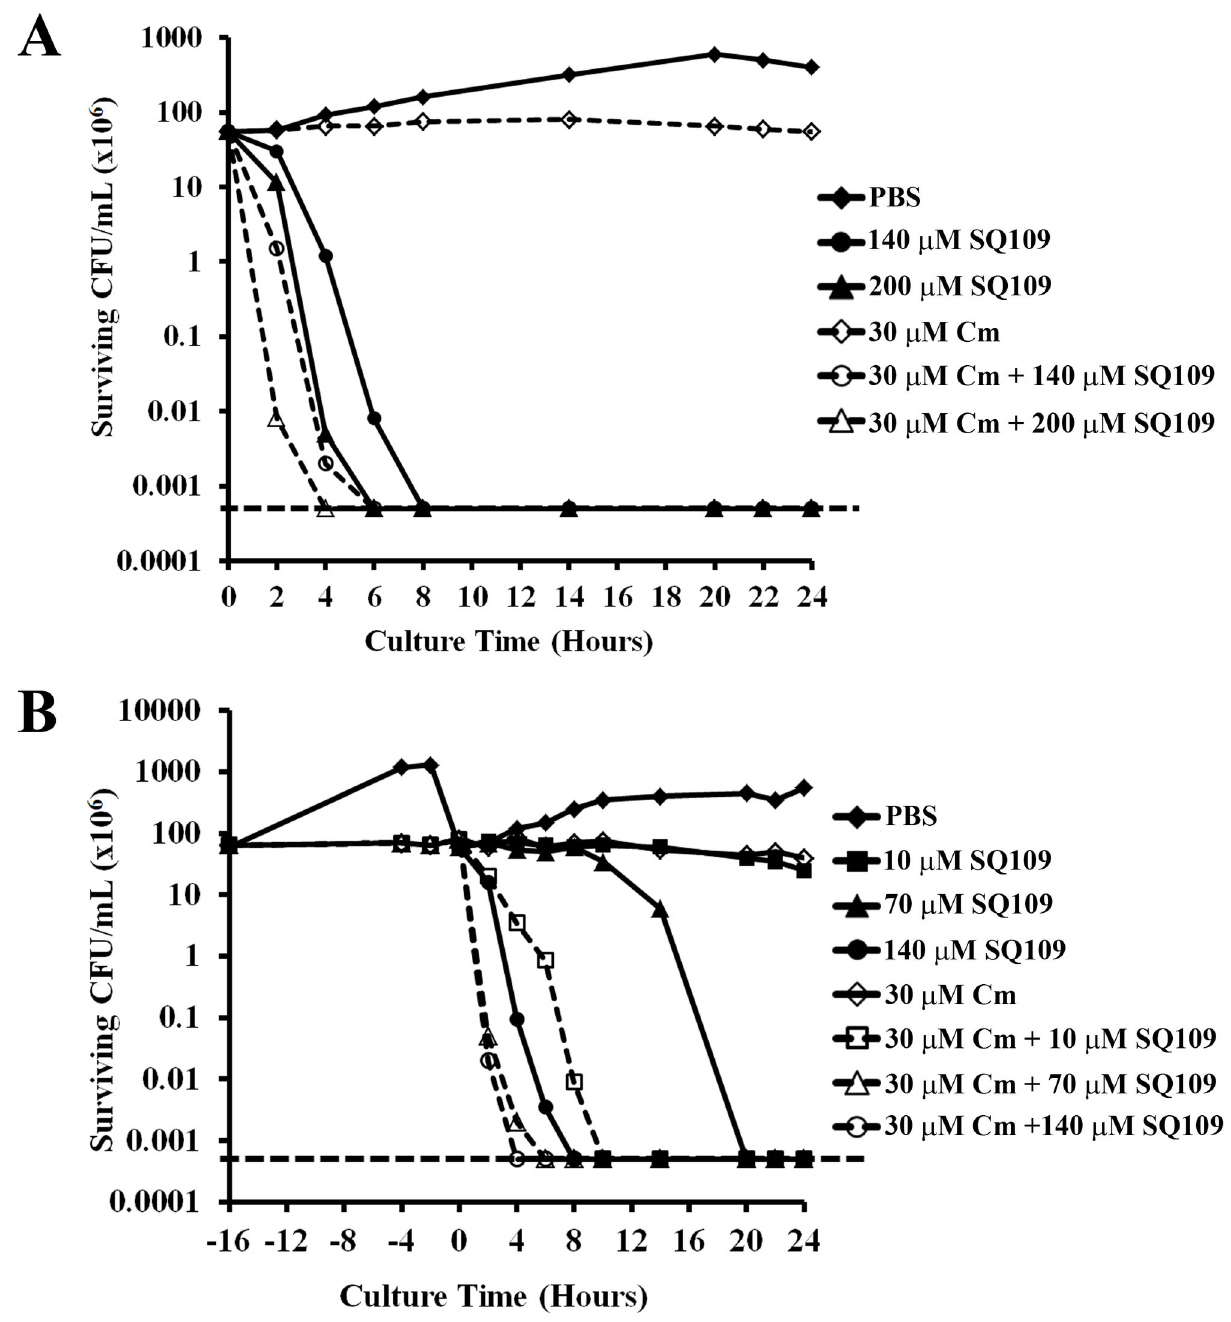
Figure 2. Antibacterial activity of SQ109 against slow-growing H. pylori and synergy with chloramphenicol, Cm. A predetermined bacteriostatic concentration of Cm (30 µM), was used to induce slow growth. Synergistic effects of SQ109 and Cm was then examined using two approaches: A ) H. pylori strain G27 liquid cell cultures were treated simultaneously with 30 µM Cm and SQ109 (0 µM, 140 µM, and 200 µM) (open symbols), and the cells were monitored for 24 h, and B ) H. pylori strain G27 cells were initially incubated with 30 µM Cm for 16 h in liquid culture medium before being split into multiple samples for further incubation with varying concentrations of SQ109 (0 µM, 10 µM, 70 µM or 140 µM) (open symbols) plus Cm. In both approaches, bacterial cells incubated with only PBS, SQ109 (0 µM, 10 µM, 70 µM, 140 µM or 200 µM) or Cm alone, were used as controls (closed symbols). The data are representative results from three independent experiments. The horizontal dashed line on each graph indicates the limit of detection (500 bacteria).